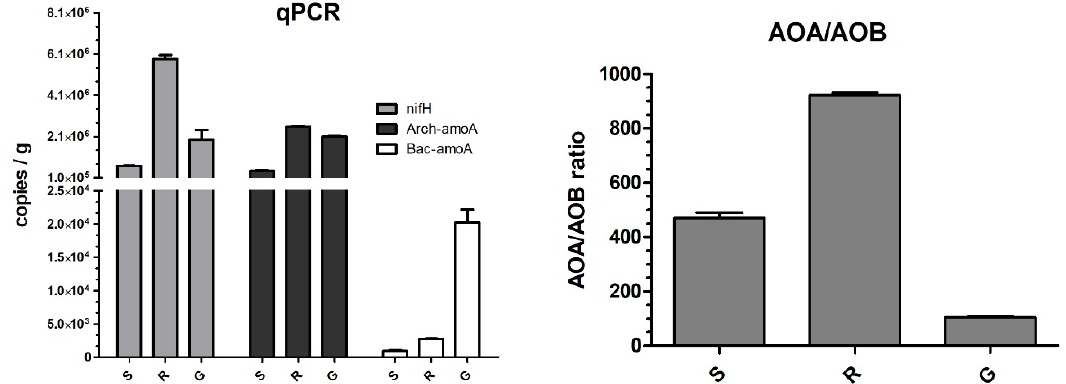
Figure 2. Quantitative PCR (qPCR) of genes associated with nitrogen fixation and ammonia oxidation and the archaeal and bacterial ammonia oxidation ratio (AOA/AOB). The bacterial nitrogen fixing gene (nifH), archaeal (AOA), and bacterial (AOB) ammonia-oxidizing genes in sediment (S), gravel-like (G), and rock sample (R). Assays were performed in triplicate ( n = 3), bars represent standard deviation.